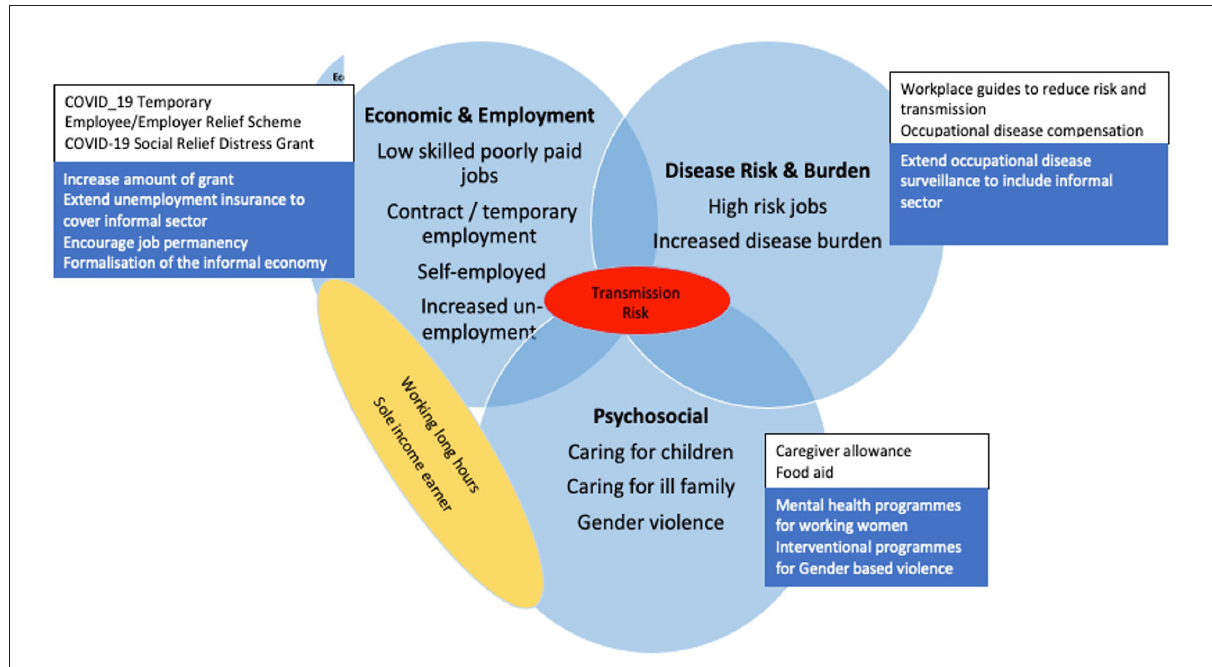
FIGURE2 Vulnerabilities, Government interventions and proposed recommendations for addressing the COVID-19 impact on South African women workers. Blue circles: vulnerability factor, red oval: transmission risk, yellow oval: overlay of economic and psychosocial vulnerabilities, white box: government intervention, blue box: